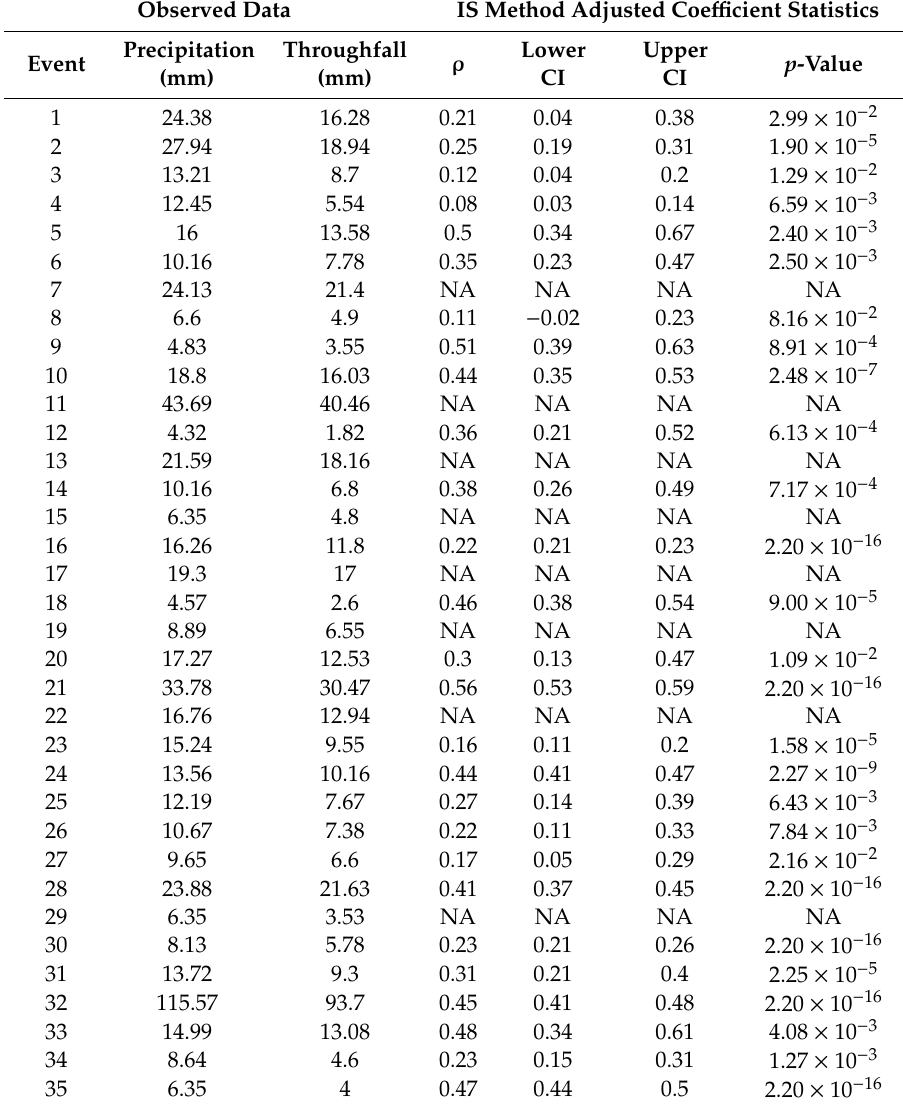
Table 1. Summary of the rainfall events and canopy free throughfall ( ρ ) coe ffi cient obtained by the individual storm (IS)